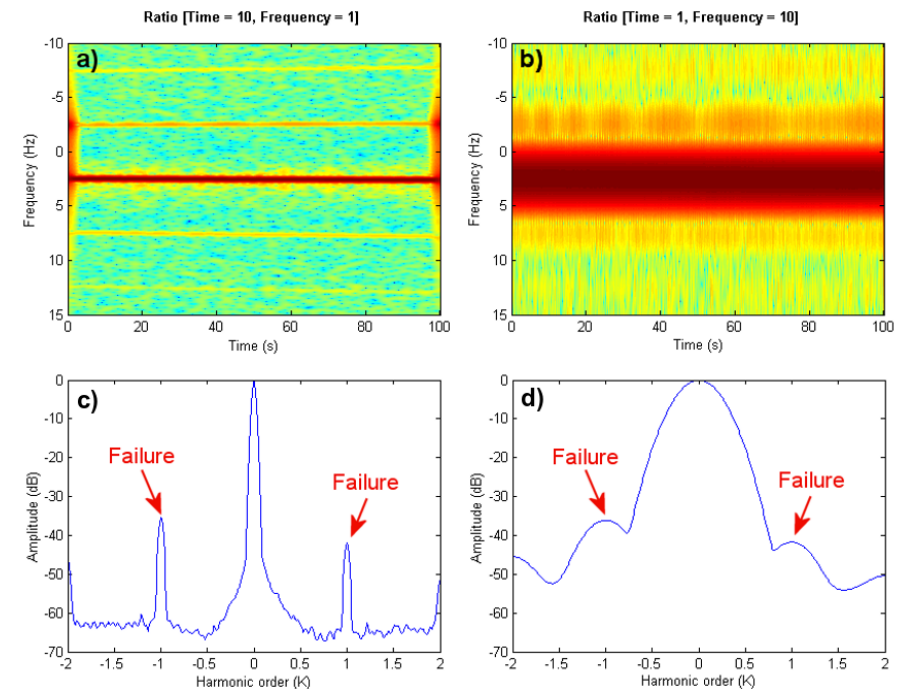
Figure 6. Examples of the time/frequency space generated with a phase current using a Gaussian window of ratio 10/1 ( a ) and its HOTA solution ( c ). The time/frequency space obtained with the same current but using a Gaussian window of ratio 1/10 is shown in ( b ), and its HOTA solution is shown in ( d